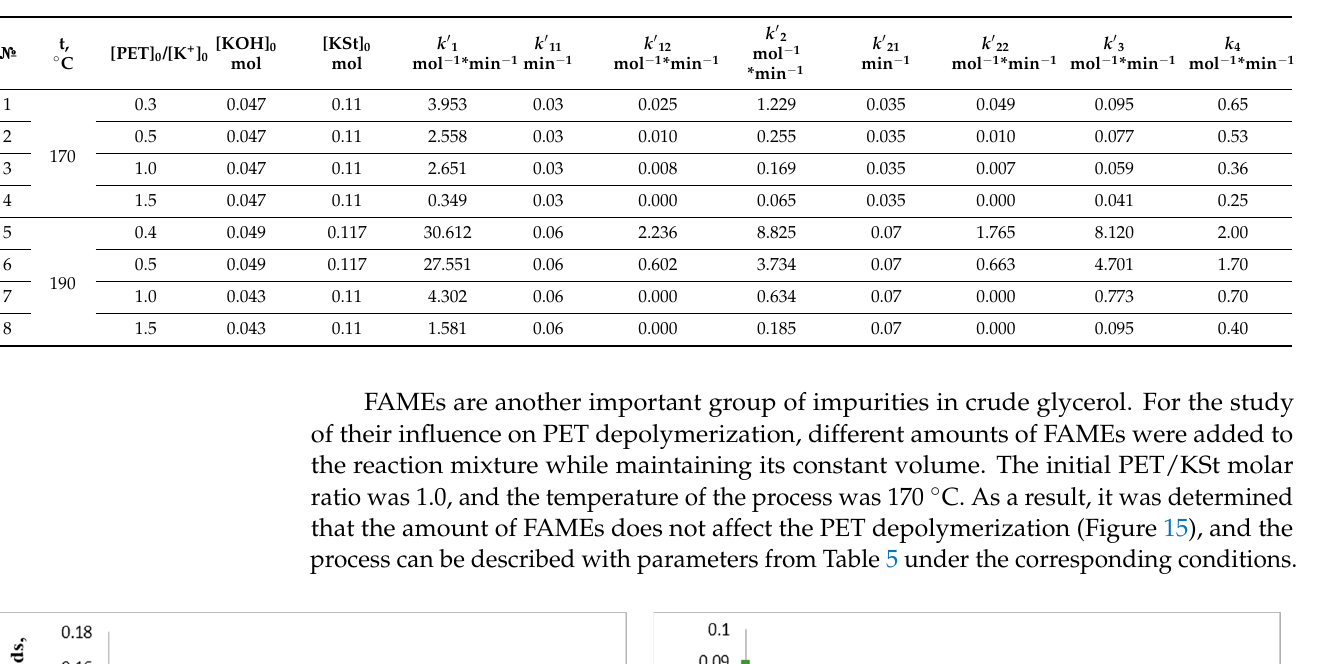
Table 6. Parameters of Equations (3)–(14) according to Equations (15)–(21) for different temperatures and PET/KSt molar ratioss.